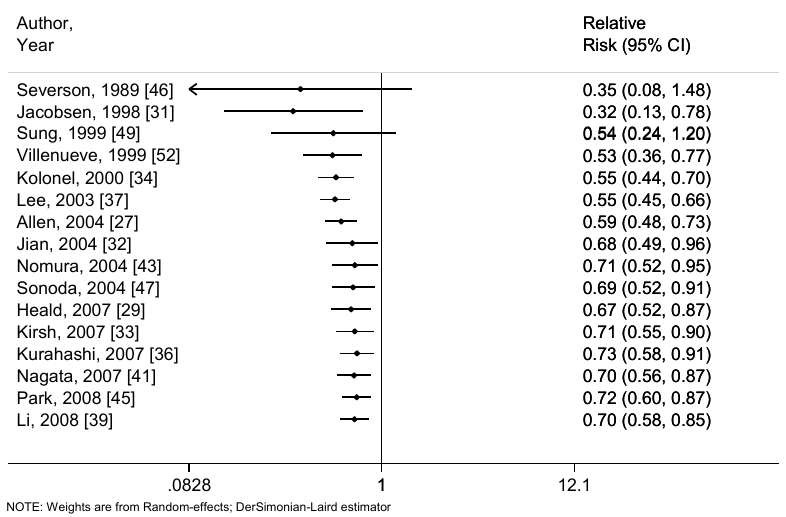
Figure A2. Funnel plots for ( A ) circulating genistein and risk of prostate cancer and ( B ) circulating daidzein and risk of prostate cancer.